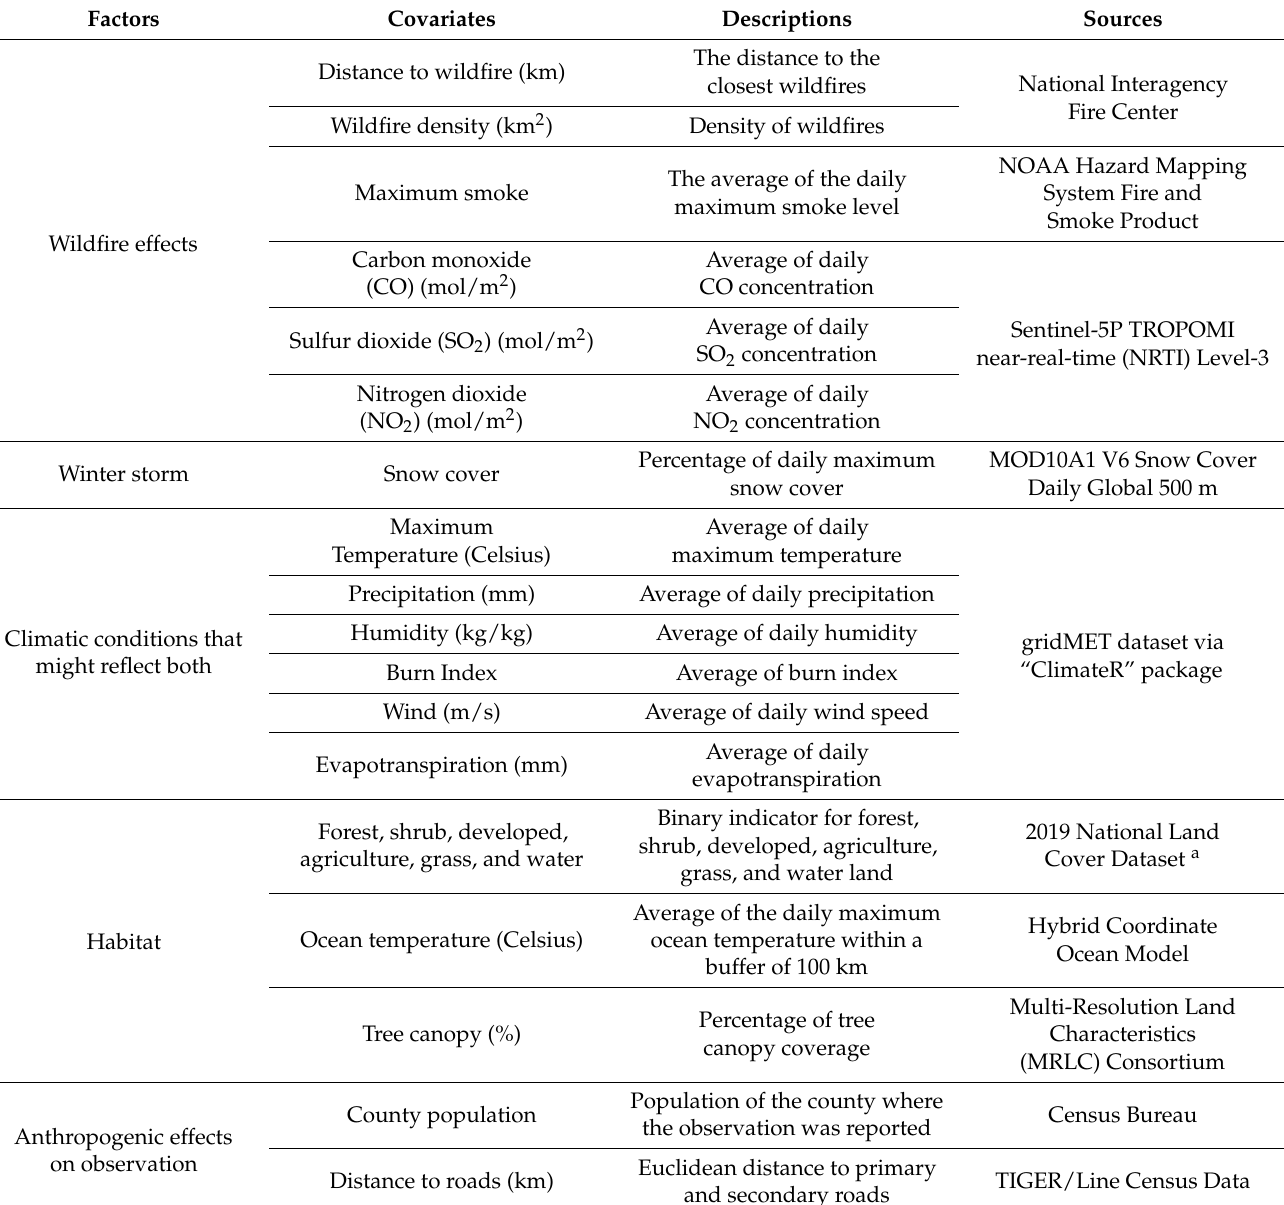
Table 1. The details and sources of the covariates that were considered to describe the potential effects on the spatial distributions of the mortality of the three